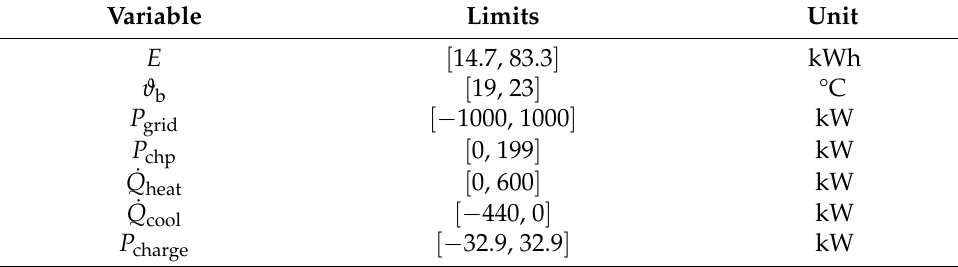
Table 2. Constraints on states and inputs for System (2). In the following, we will refer to upper and lower limits by appending max and min as superscripts,